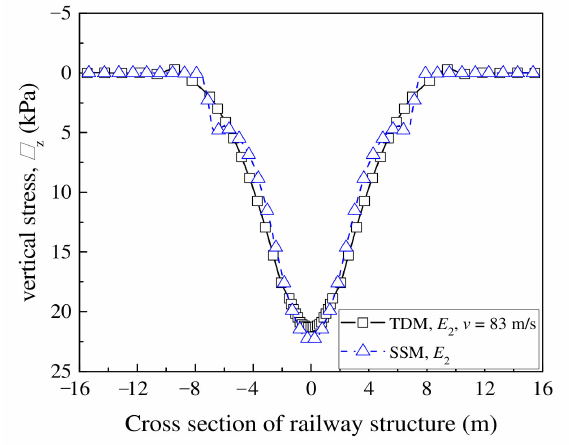
Figure 5. Vertical stress in a cross-section of the railway